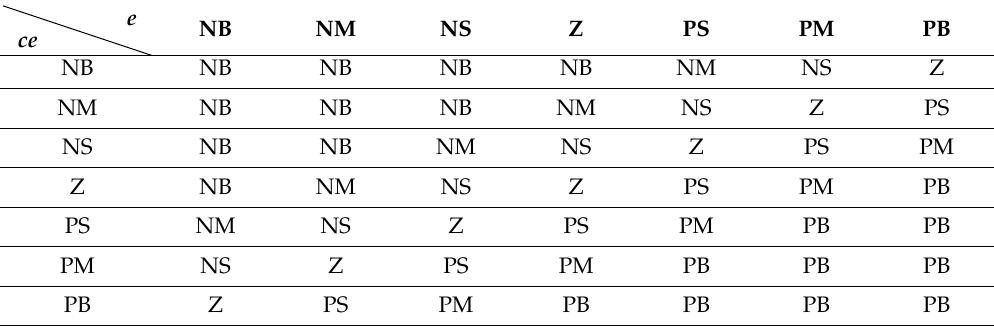
Table 3. Rule base of Fuzzy